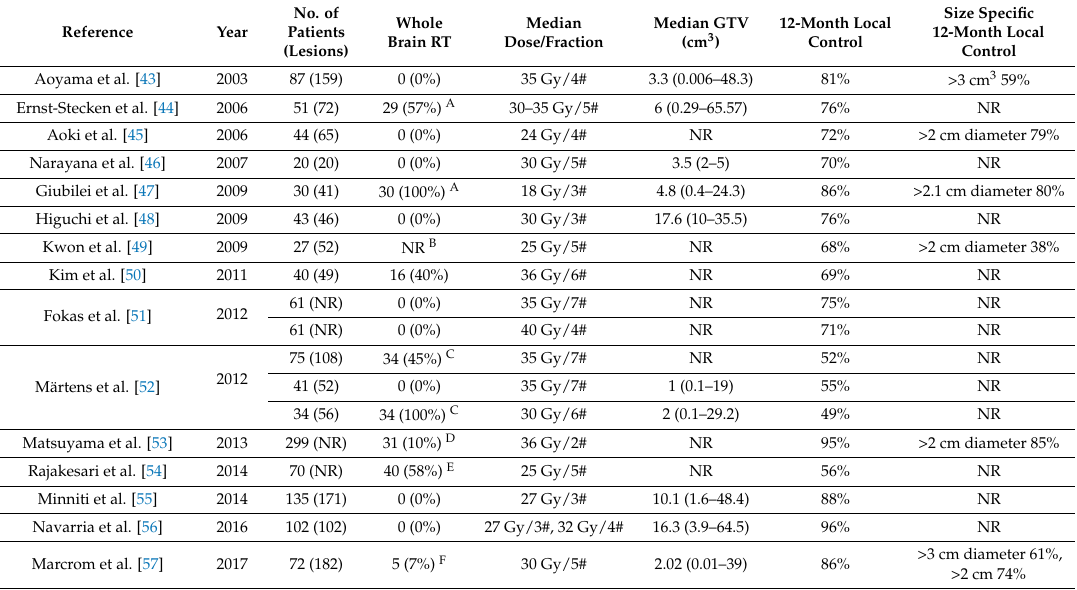
Table 2. Fractionated stereotactic radiotherapy for brain metastasis